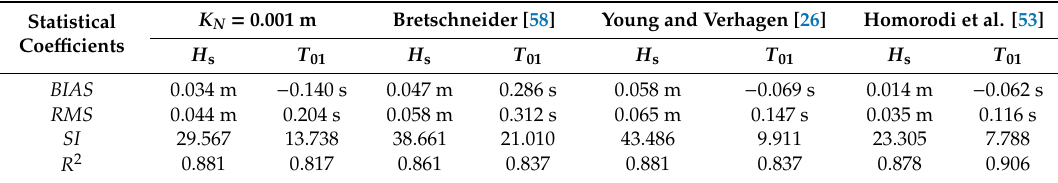
Table 4. Coefficients related to wave heights and periods measured and computed referring to the October period. BIAS , bias parameter; RMSE , root mean square error; SI , scatter index; R 2 ,correlation coefficient.